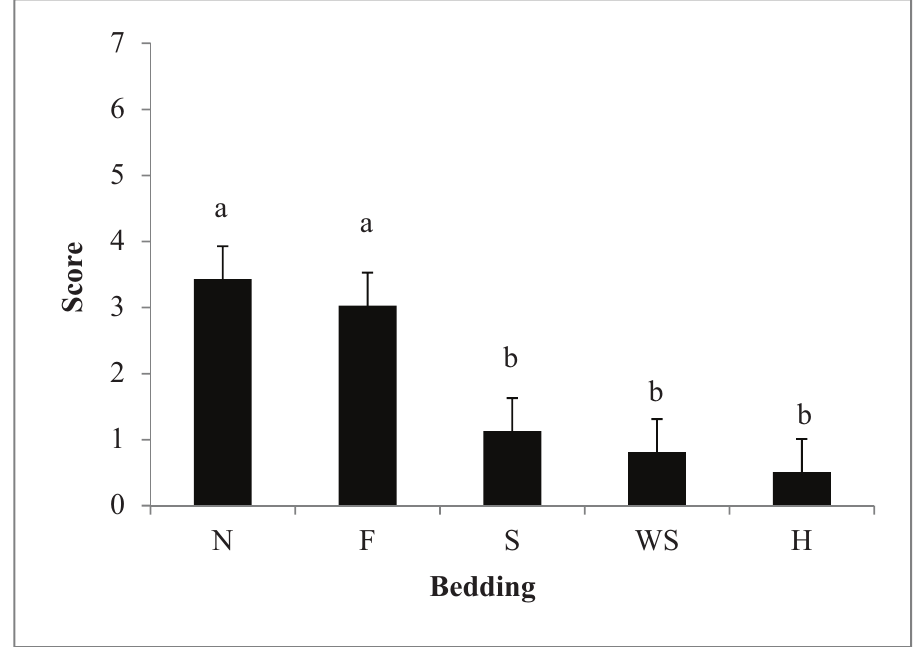
Figure 1. Least Squares means ± 0.53 for weaned pig scores with the use of different types of bedding materials ( P < 0.01). Beddings abbreviated by N = nothing, F = feed, S = sand, WS = wood shavings, H = hay. Bedding was rated based on a score system, which was calculated by the sum of slips, falls, and vocalizations. n = 60 observations/bedding